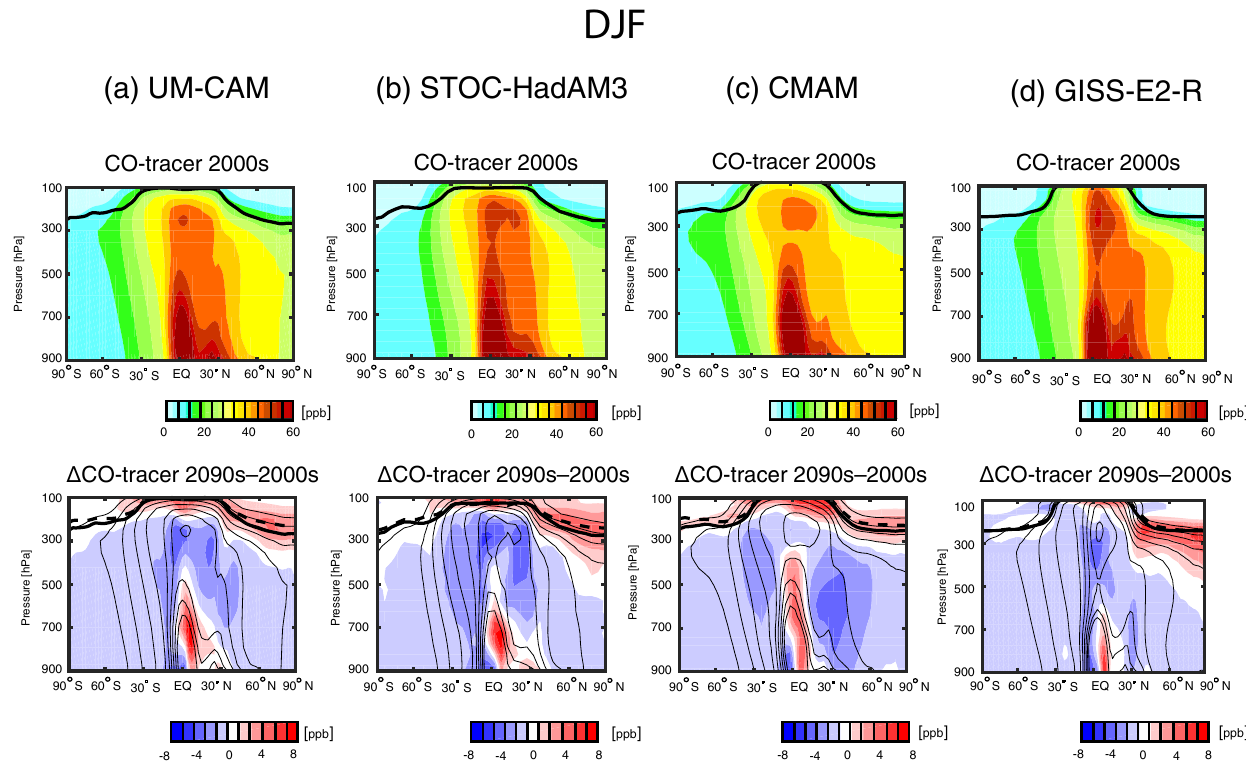
Figure 2. Top panels: present-day (1995–2006) boreal winter (DJF) 10-year climatological mean zonal-mean CO-tracer distribution for (a) UM-CAM, (b) STOC-HadAM3, (c) CMAM, and (d) GISS-E2-R CCMs. The thick black solid line represents the present-day (DJF) zonally averaged thermal tropopause. Bottom panels: differences between 2090–2099 (RCP 8.5) and 1995–2006 (present day) DJF climatological mean zonal-mean CO distributions. Thin black contours denote the present-day DJF climatology. The thick solid and dashed lines represent the DJF zonally averaged thermal tropopause for present-day and the 2090s (RCP 8.5) climatologies. Grey shading indicates where results are not significant at p < 0 . 05 as evaluated with a Student’s t test using 10 years of data for the 2090s (RCP 8.5) and present-day